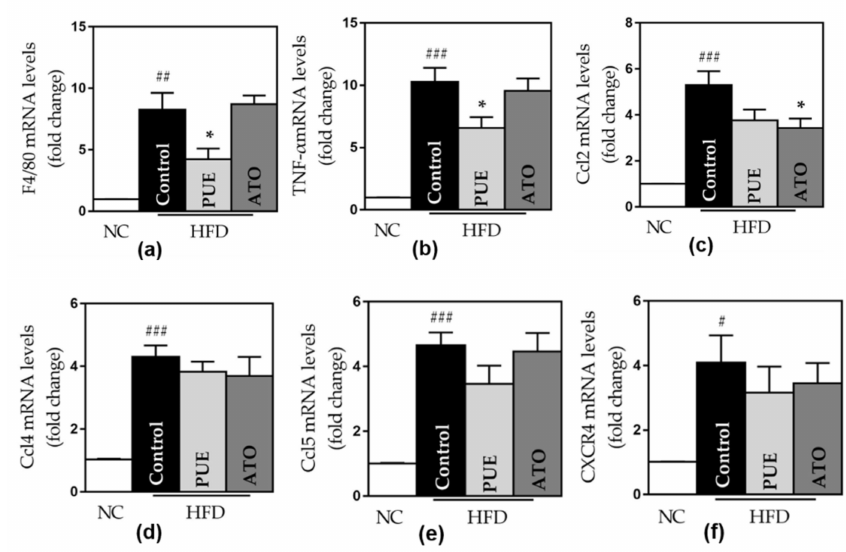
Figure 6. Pro-inflammatory gene expression. The expression of ( a ) F4/80, ( b ) TNF- α , ( c ) CCL2, ( d ) CCL4, ( e ) CCL5, and ( f ) CXCR4. Data represent mean ± standard error of the mean (SEM). # p < 0.05, ## p < 0.01 and ### p < 0.001 versus the NC group, and * p < 0.05 versus the control group. ATMs: adipose tissue macrophages, NC: normal chow, HFD: high rat diet, PUE: puerarin, ATO: atorvastatin.